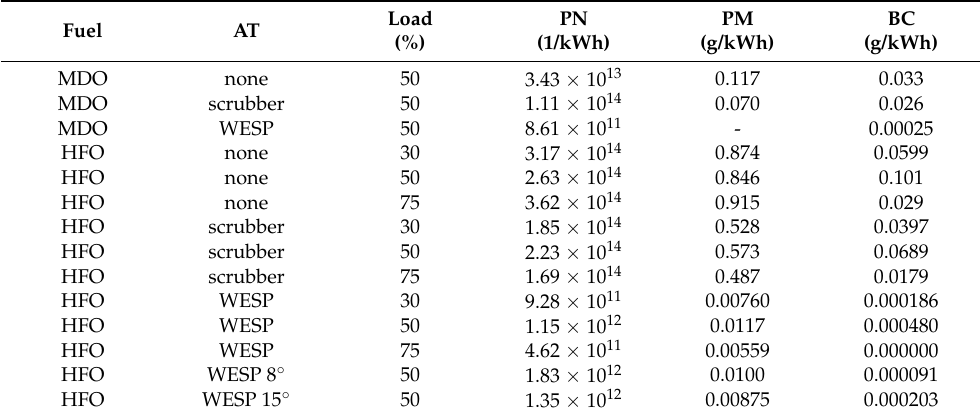
Table 3. Particle number (PN), particulate matter (PM) and black carbon mass (BC) emissions per energy engine produced from the measurements. AT refers to aftertreatment. Note that only part of the exhaust flow entered the system and reported per energy values resemble achievable values with upscaled system designed for entire exhaust flow of the